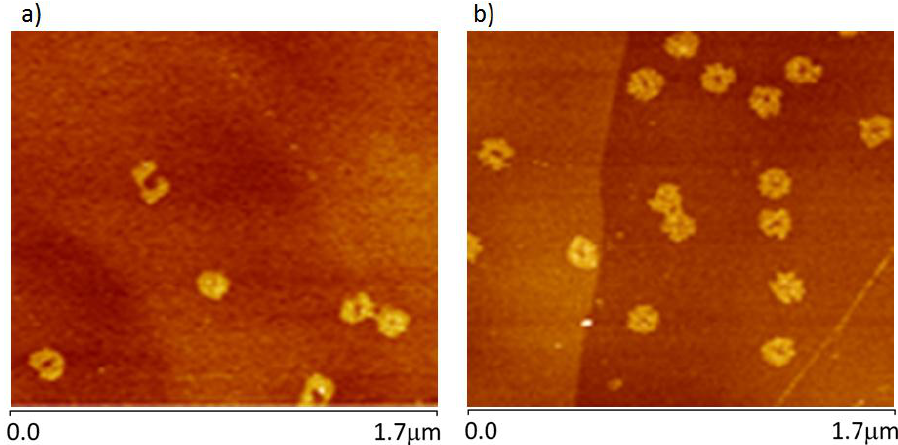
Figure 4. AFM topography images of cDO reacted with HOPG for 10 seconds: ( a ) (cDO); ( b ) constructs with short ssDNA extensions (cDO E ).